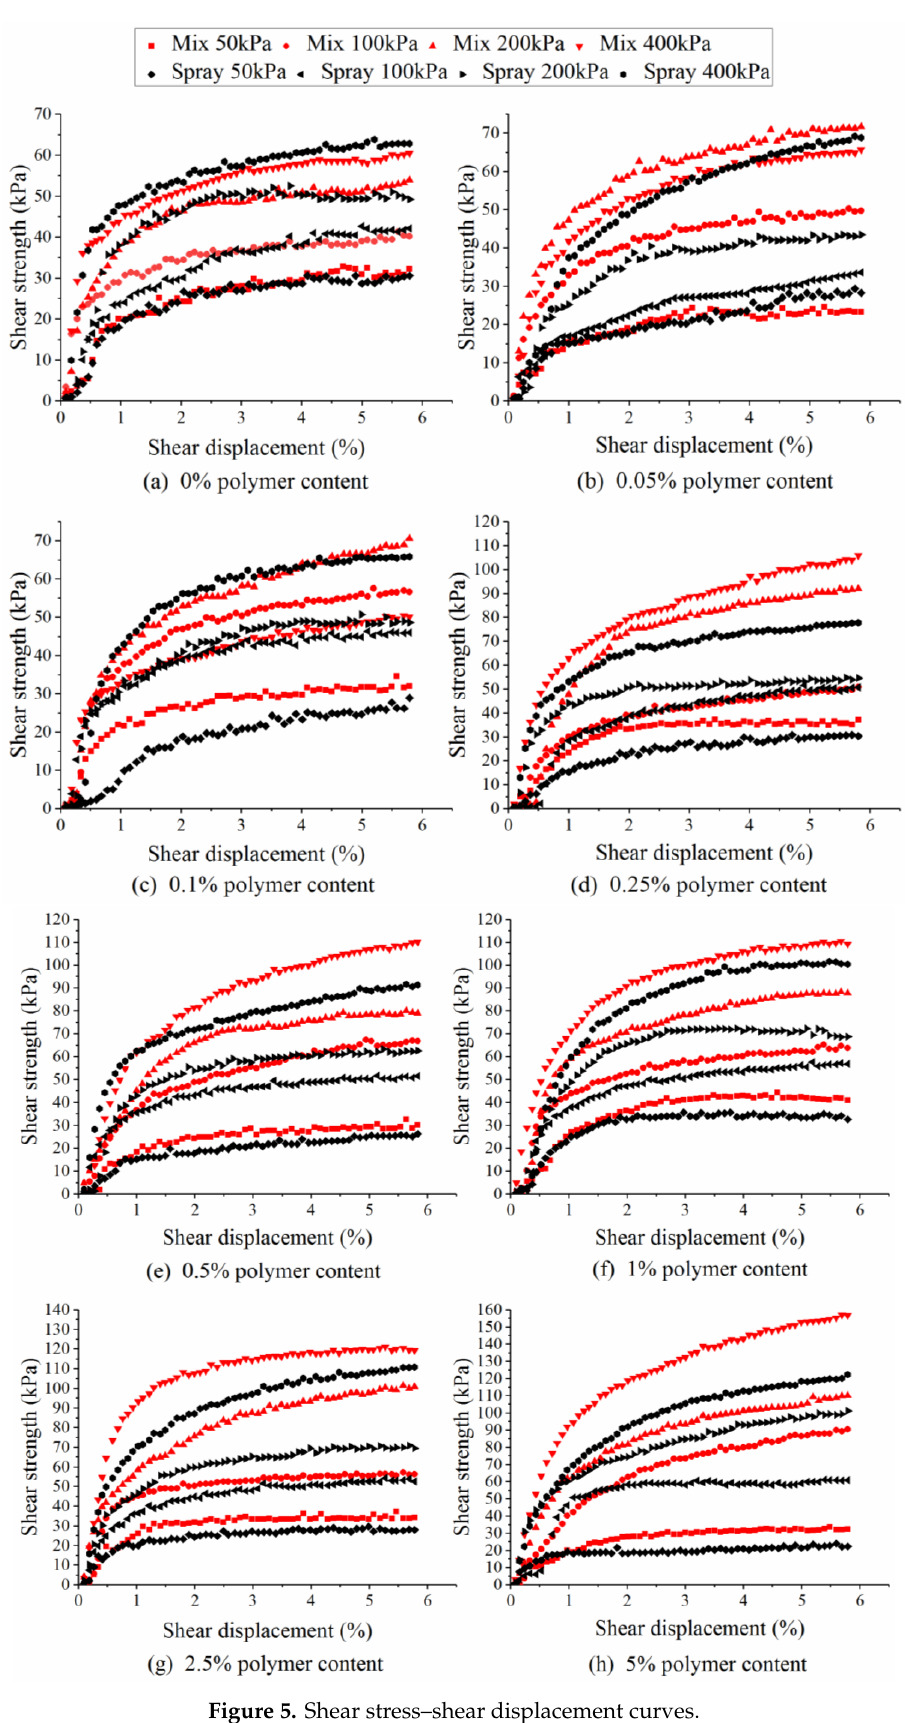
Figure 5. Shear stress – shear displacement curves.